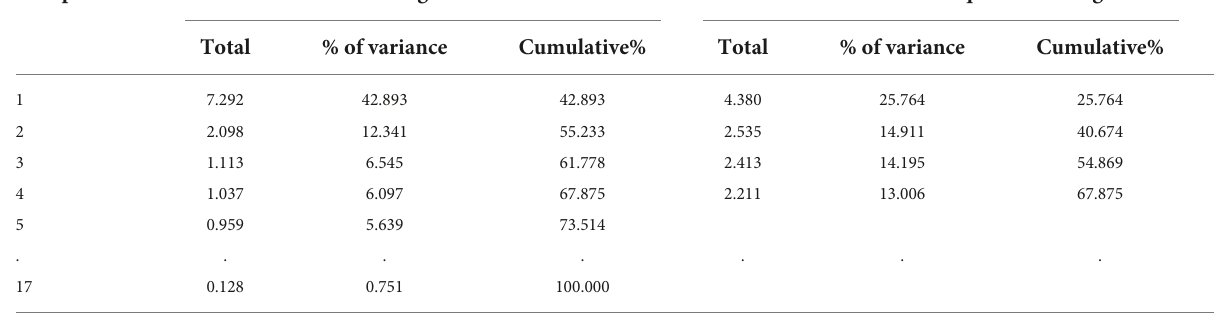
TABLE 6 Total variance